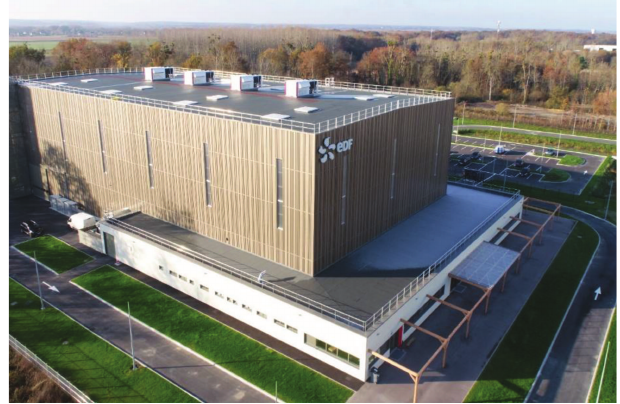
Fig. 3. EDF’s industrial